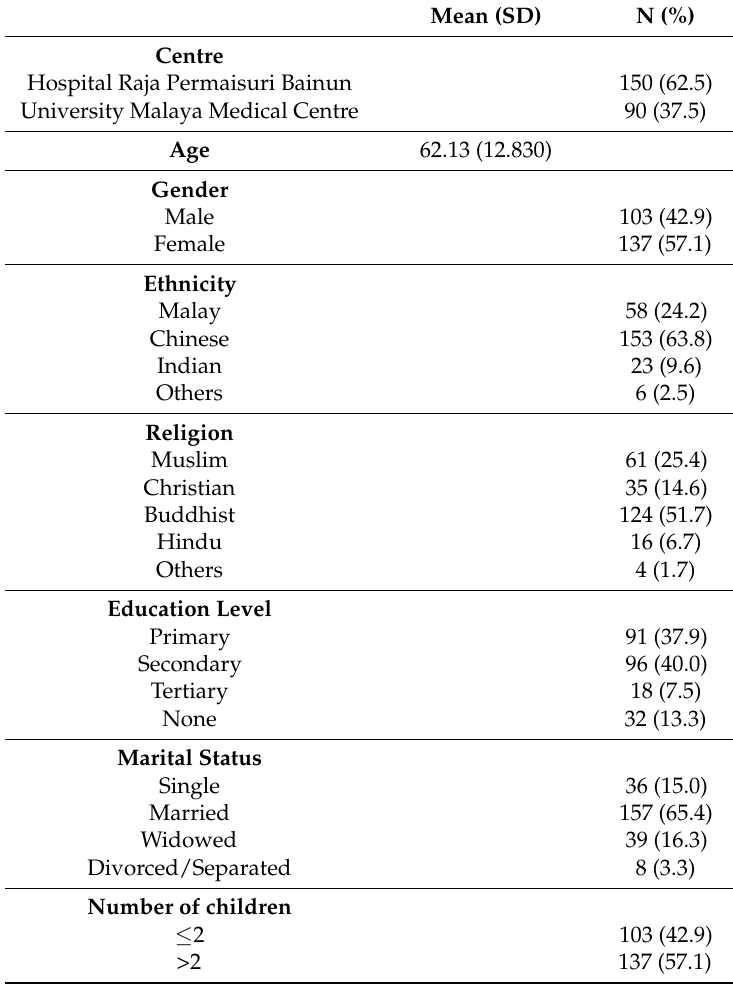
Table 1. Socio-demographic characteristics of palliative care patients ( n =